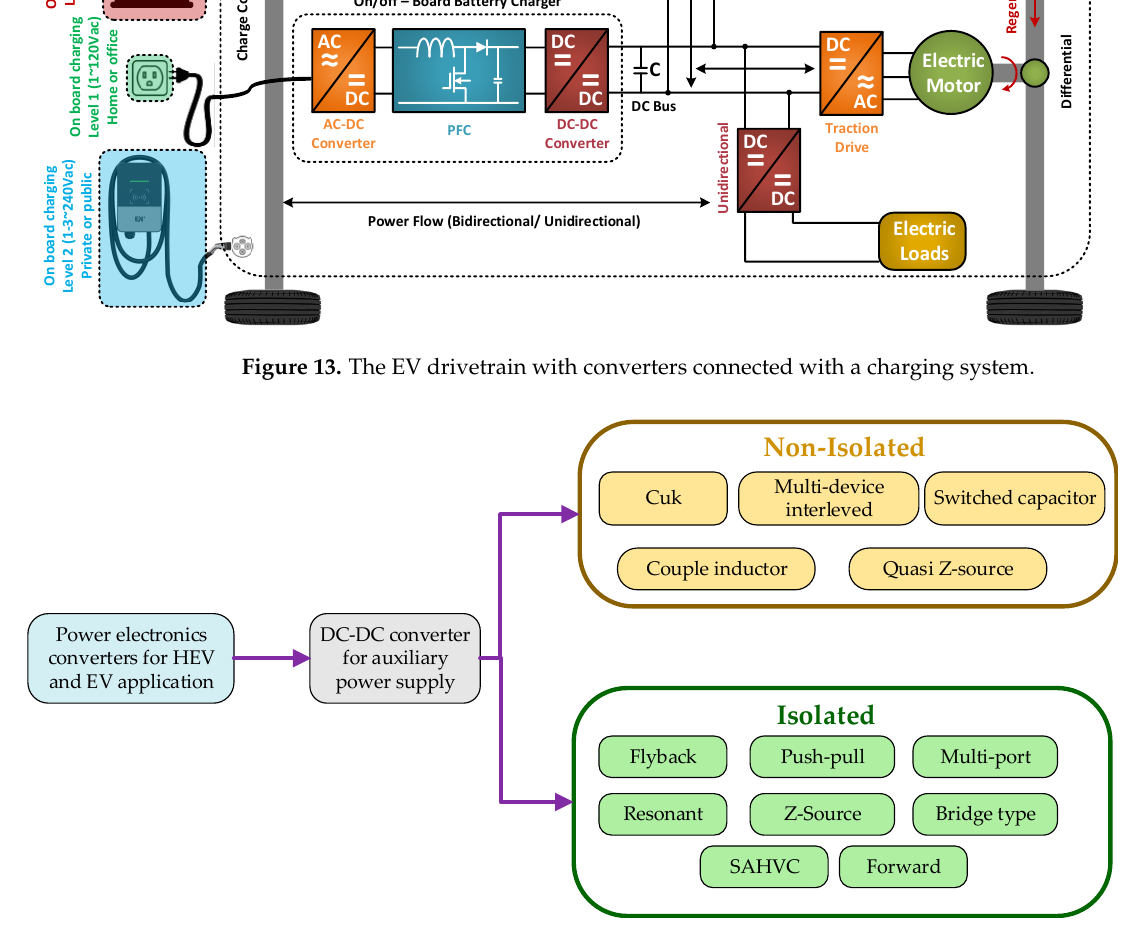
Figure 14. Power electronics converter types in EV applications.